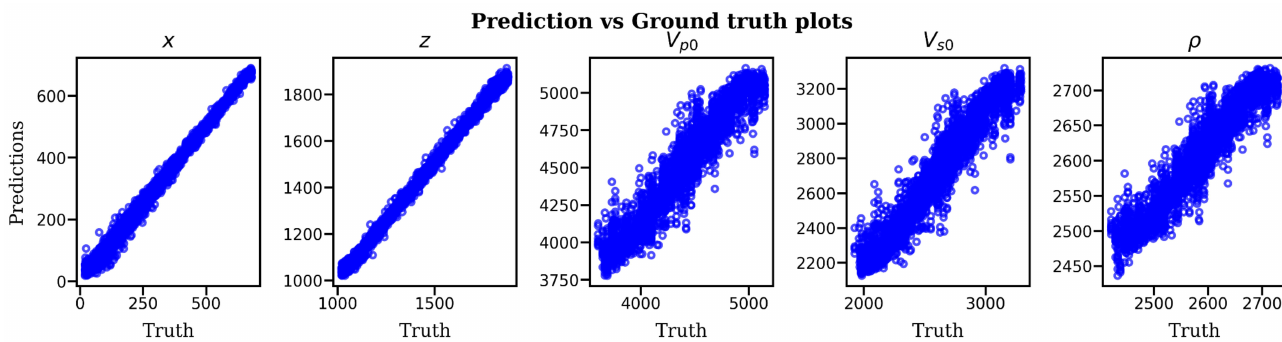
Figure 6. Scatter plots of predictions versus ground-truth values of event depth location and velocity model parameters v p0 , v s0 and ρ . The plots show strong positive